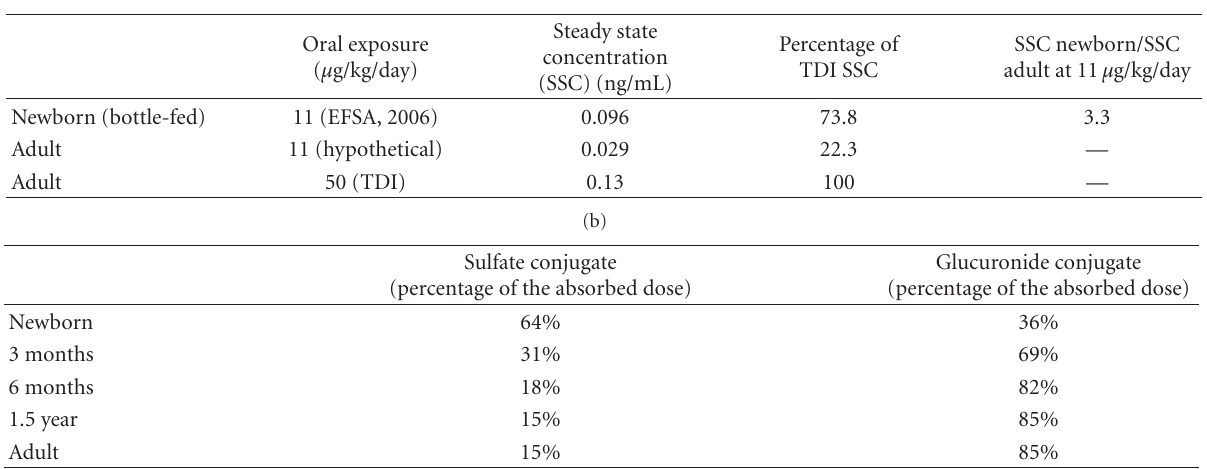
Table 1: BPA steady state concentration in blood after oral exposure by 11 μ g/kg/day in bottle fed newborns. The steady state concentration (SSC) is compared to a steady state concentration in an adult exposed to 11 μ g/kg/day and to the 50 μ g/kg/day on the oral route. It can be seen that the steady state concentration in the newborn is three-fold higher than in the adult due to the fact that the metabolism of BPA by glucuronidation is impaired in the newborn. However, the SSC in the newborn does not exceed the SSC of an oral dose of 50 μ g/kg/d. The oral dose of 50 μ g/kg/d equals the tolerated daily intake derived from animal studies. It is thought to be a level without adversely influencing the health calculated for the population older than 3 months. The SSC of 50 μ g/kg/d has been simulated with the model parameters of an adult. Relative contribution of the two pathways in the metabolism of BPA in relation to age (and related to age extent of impaired glucuronide conjugation). 85% of a dose of BPA is metabolized to the glucuronide conjugate to and the remaining 15% to the sulfate conjugate in the adult. The enzyme which mediates the conjugation to BPA-glucuronide (uridine diphosphate-glucuronosyltransferase 2B15, UTG 2B15) is expressed at birth to only 10% of the adult level. The expression levels reach adult levels by the age of 1.5 years. The relative percentage of the glucuronidation pathway depends on the expression level of UTG 2B15. In the newborn only 36% of the absorbed dose is metabolized via glucuronidation, whereas 64% of the absorbed dose is